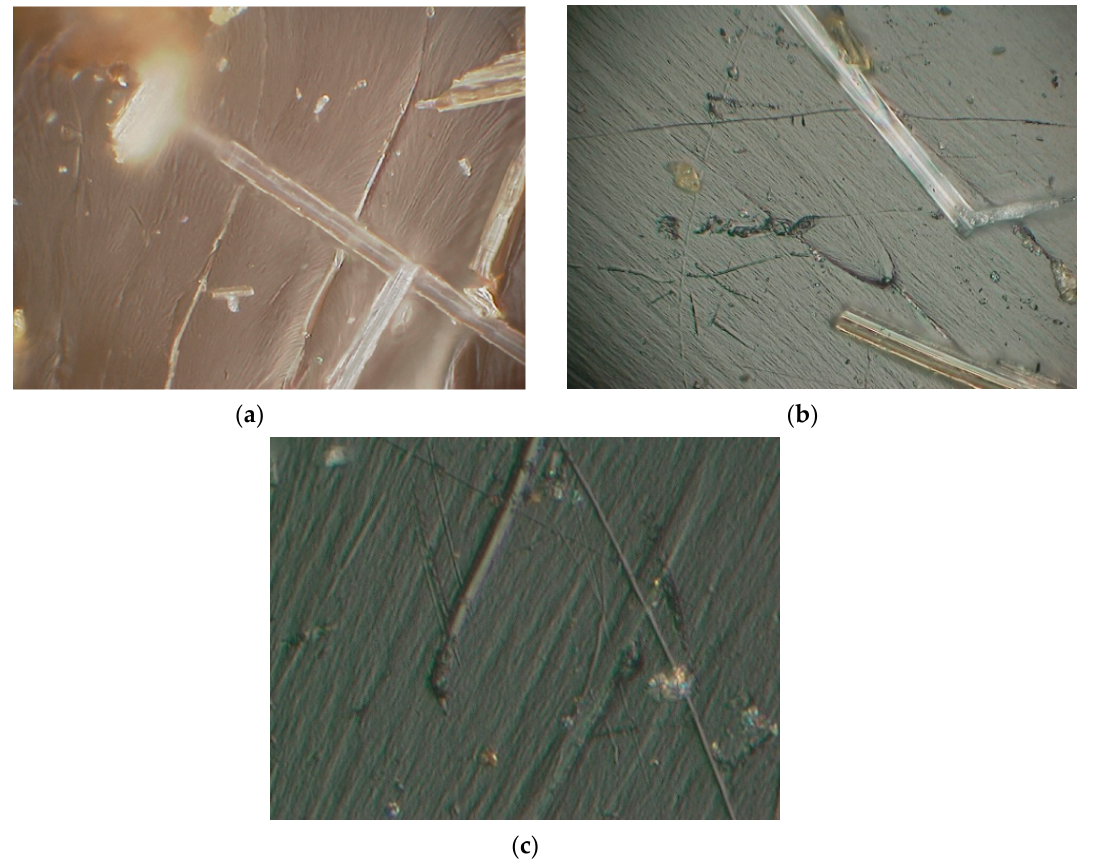
Figure 9. The fracture surfaces of 10 wt.% GF/p-DCPD composite (( a ) Room temperature, ( b ) CT (cryogenic temperature, − 160 °C), ( c ) CT with 2 wt.% decelerator, up to 2000× magnification).